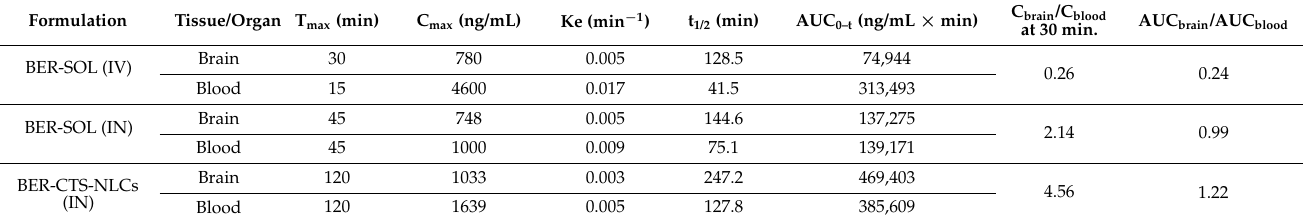
Figure 8. The levels of berberine (BER) in rat plasma after administration of BER-SOL (IV), BER-SOL (IN), and BER-CTS-NLCs (IN). Table 5. Pharmacokinetic parameters of BER-SOL (IV), BER-SOL (IN), and BER-CTS-NLCs